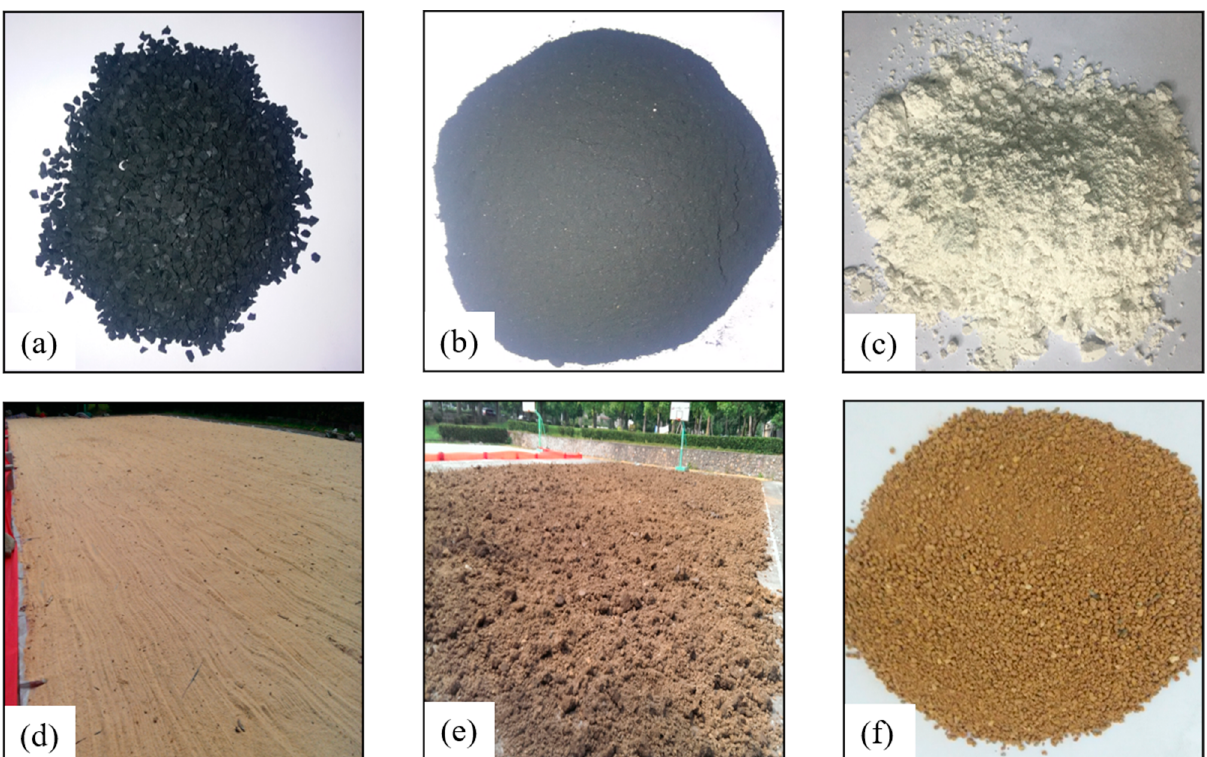
Figure 1. Model soil preparation material: ( a ) Rubber particle (2–4 mm), ( b ) Rubber powder (40–60 mesh), ( c ) Kaolin (80 mesh), ( d ) Drying of sawdust, ( e ) Drying of undisturbed soil, ( f ) Undisturbed silty clay powder. Table 3. Group C: rubber particles + undisturbed soil (rubber granular soil). Table 1. Group A: sawdust + undisturbed soil (sawdust soil). Group Rubber Particles: Undisturbed Soil: Water Group